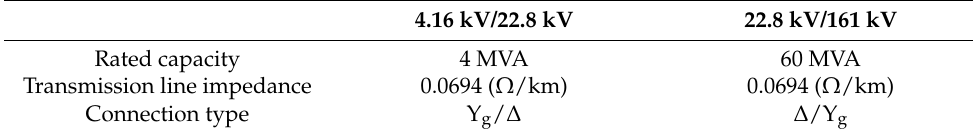
Table 2. Parameters of a transformer and transmission